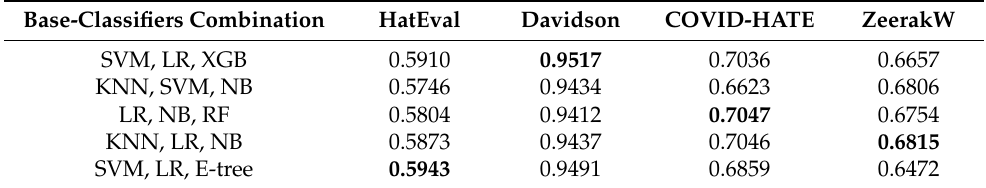
Table 10. F1-score of the standard stacking on test sets. Bold entries show the highest performance for each classifier on each dataset.